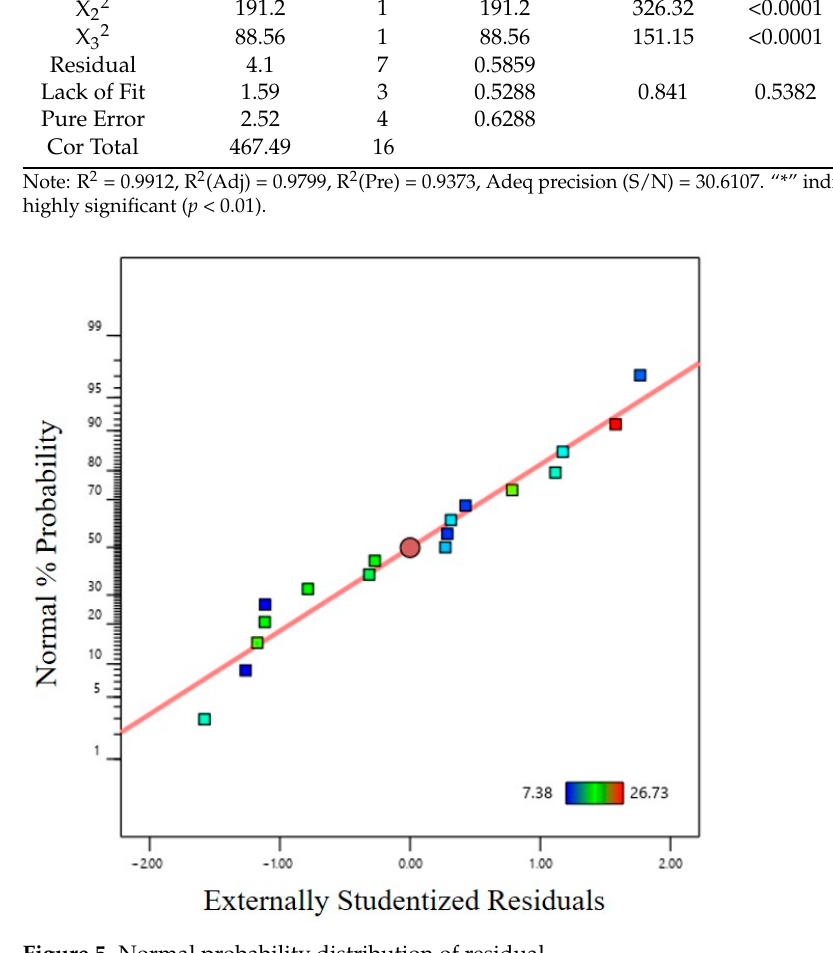
Figure 6. Distribution of actual and predicted values of maximum thinning rate. 3.3. Response Surface Analysis of Regression Models Figures 7–9 show the contour plots and corresponding three-dimensional response surface graphs of the interactions among response factors when the maximum thinning rate of the magnesium alloy sheet was taken as the response variable. Figures 7 and 8 show that the contours on the Y plane are dense, and the contours corresponding to the changes in X 1 and X 2 /X 3 reveal elliptic characteristics. These results show that there was a significant interaction between the stamping speed and the blank-holder force, as well as between the stamping speed and the friction coefficient.